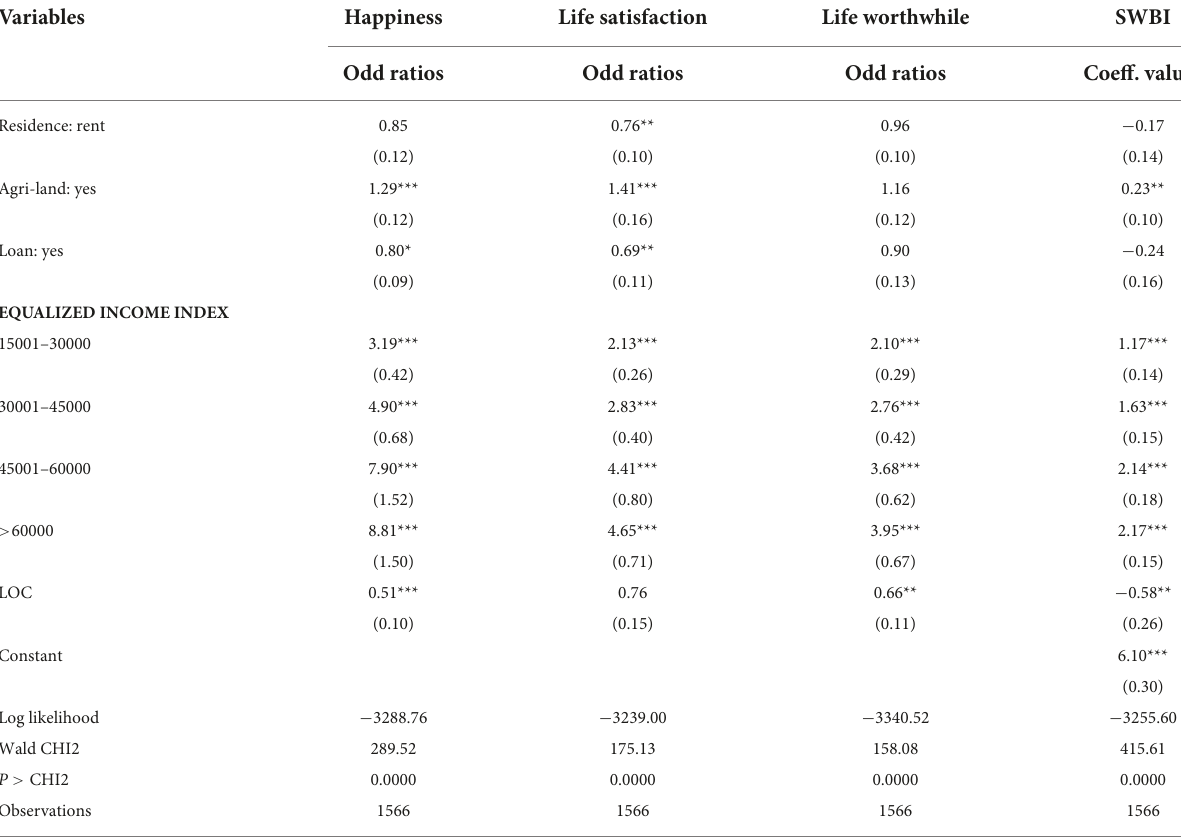
TABLE 5 Factors of household economy as determinants of subjective wellbeing method: Ordered logit model Ib.